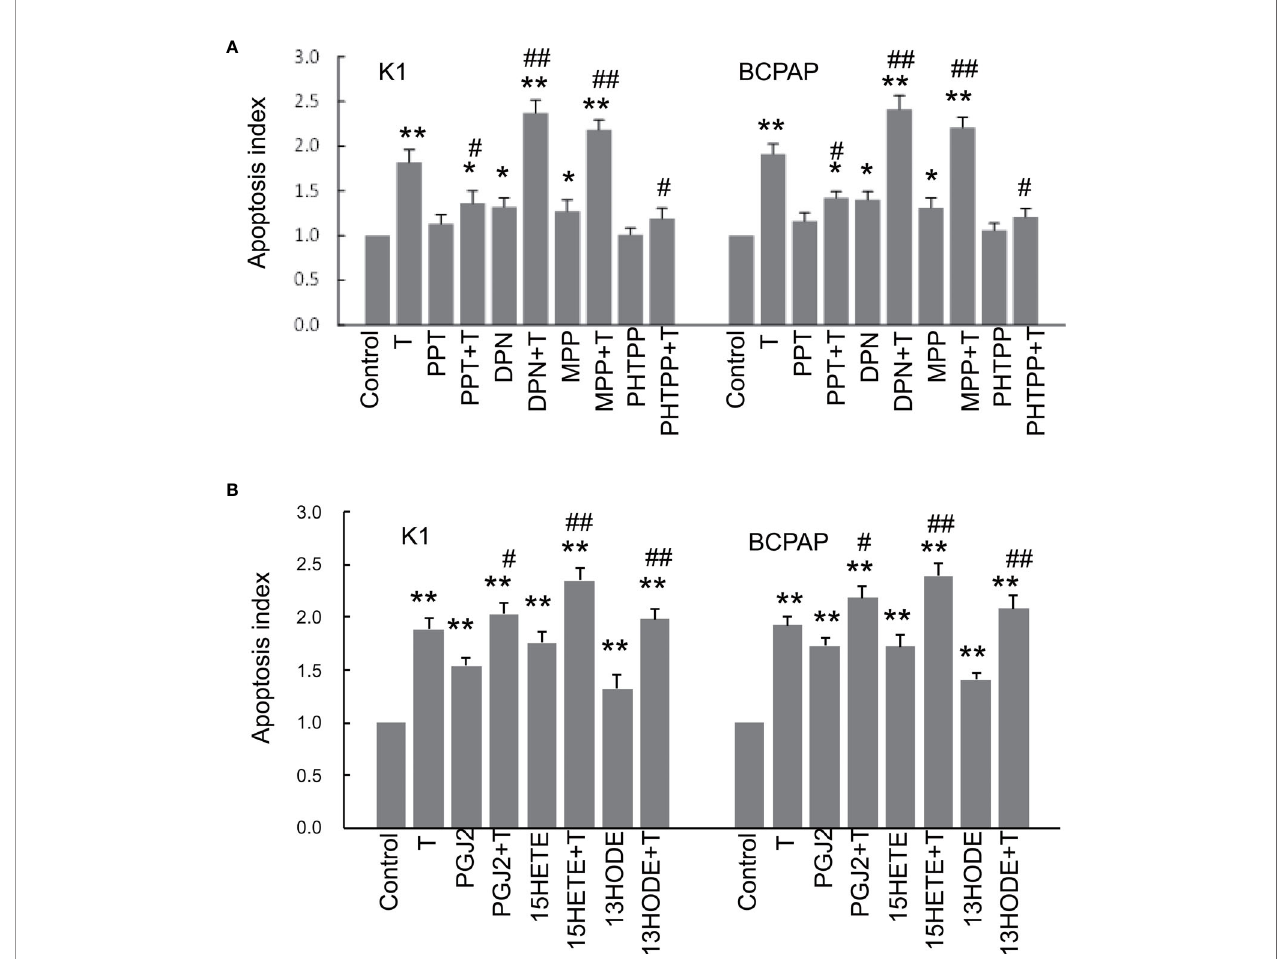
FIGURE 4 | The impact of ER modulation and endogenous PPAR g ligands on apoptosis. K1 and BCPAP cells were respectively treated with 4 different ER modulators (1 µM PPT, 1 µM DPN, 1 µM MPP, 1 µM PHTPP), 1 µM paclitaxel (T) or ER modulator plus T for 48 hours (A) . At the end of the treatment, apoptosis was measured by TUNEL assay kits (BD Biosciences, San Jose, CA). The apoptotic index was calculated as folds of the control condition (no treatment). To assess the effect of endogenous PPAR g ligands on apoptosis, cells were respectively treated paclitaxel (T) or PPAR g ligand plus T for 48 hours (B) , and apoptosis was measured as described above. The data were presented as the mean ± SD of 3 independent experiments with triplicate wells. *p < 0.05, **p < 0.01 compared with the control (0 dose); #p < 0.05, ##p < 0.01 compared with cells treated with T